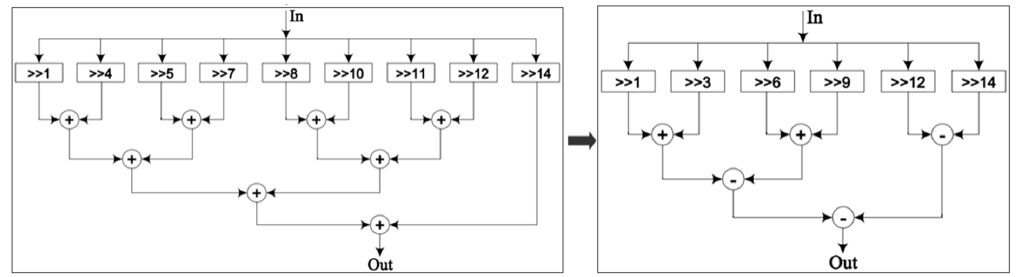
Figure 6. Hardware implementation of the constant multiplier in conventional way and canonical signed digit (CSD).